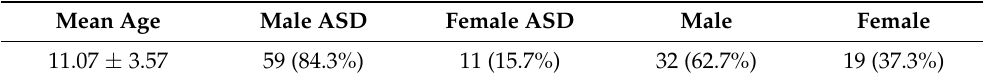
Table 1. Demographic data, sex and age.